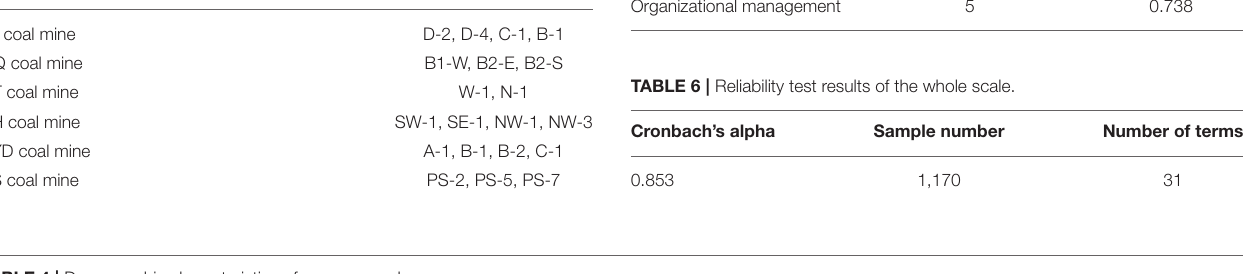
TABLE 4 | Demographic characteristics of survey